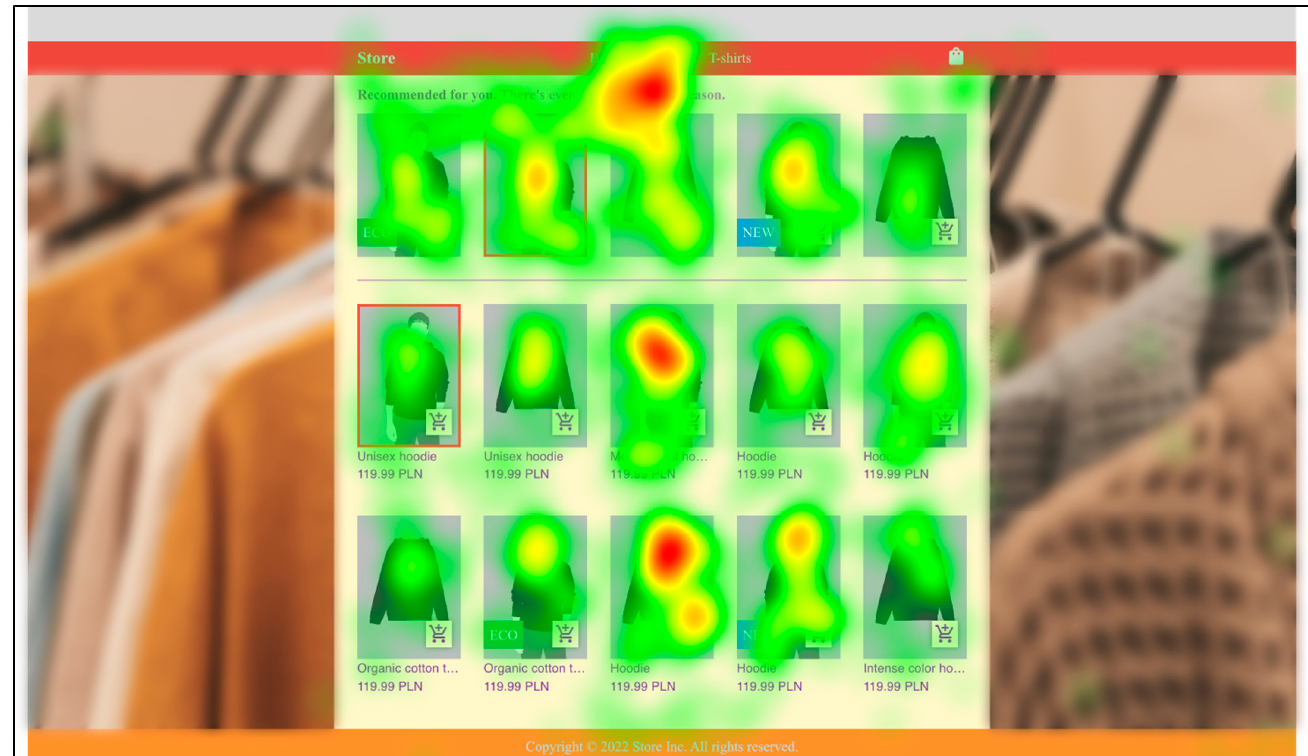
Figure 6. Aggregated heatmap for all participants for the first category (hoodies or skirts) in the aesthetic store. (The pictures of clothes and models are illustrative).